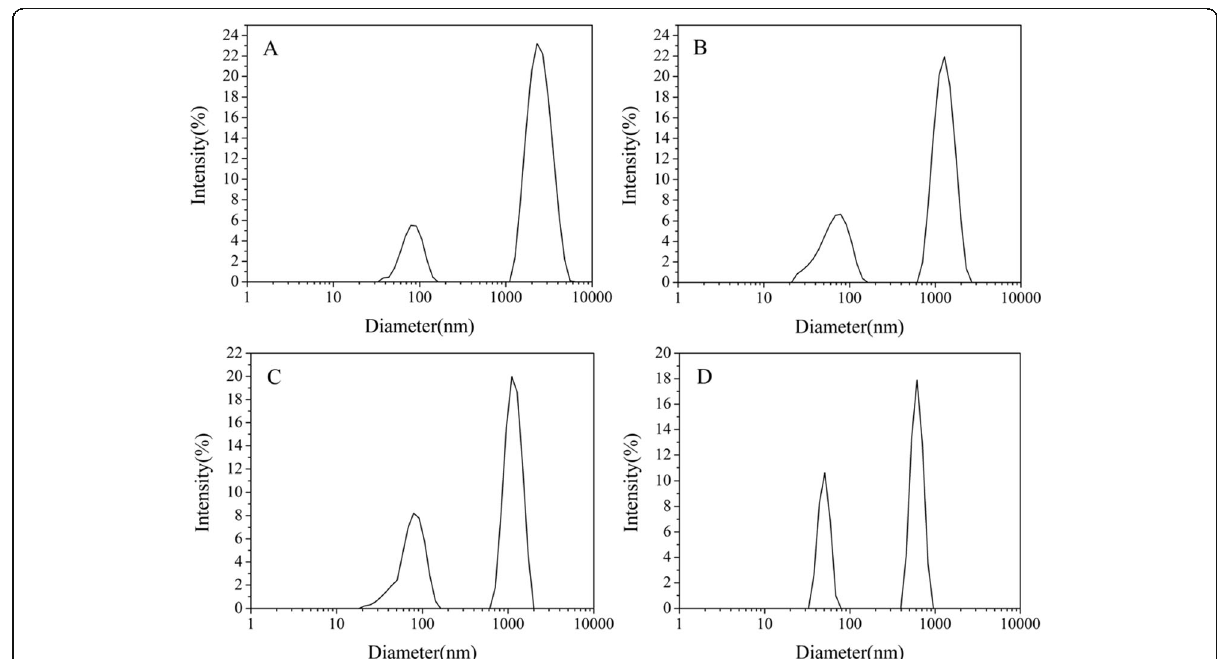
Fig. 8 The sizes and distribution of collagen aggregates determined by DLS dissolved in different concentrations of [EMIM][Ac] ( a :Col/ILs- soluble10%, b :Col/ILs-soluble30%, c :Col/ILs-soluble50%, d